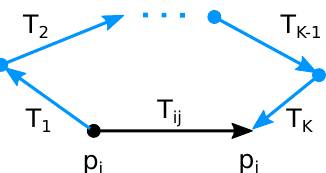
Figure 16. Verification of edge ( p i , p j ) representing transformation T ij is performed by comparison with transformation T 1 · T 2 . . . T K of alternative path (blue) between i th and j th node.